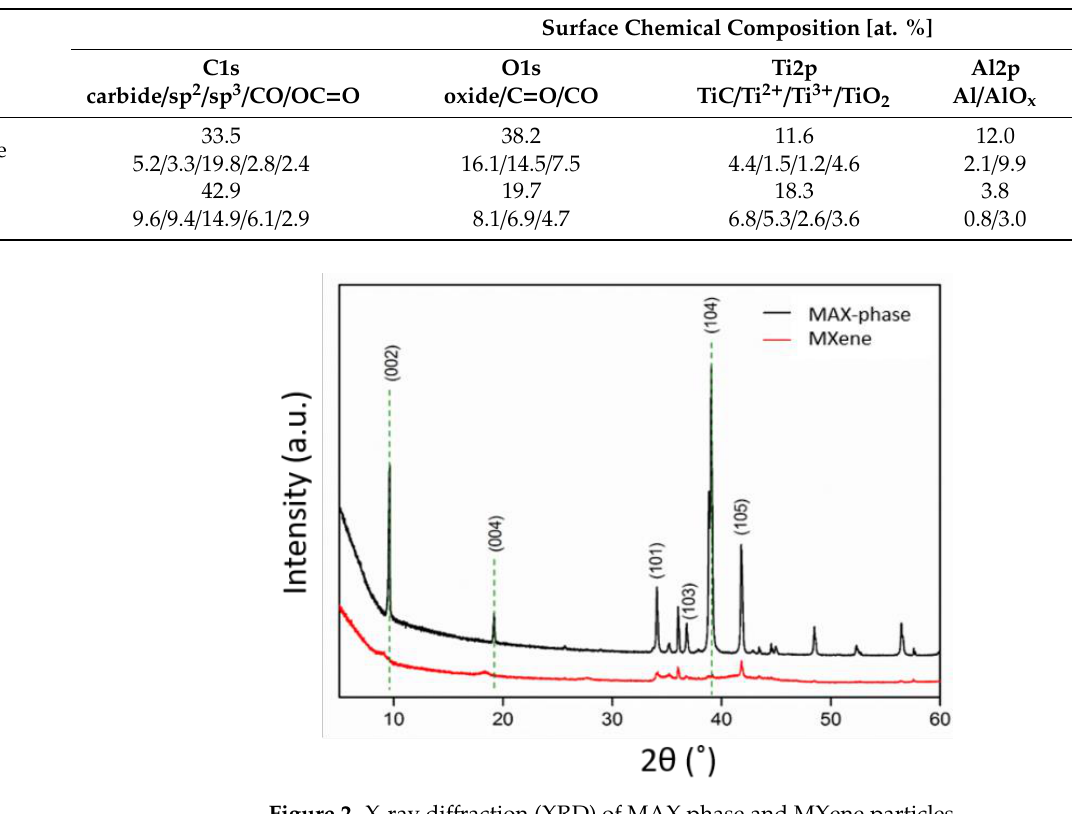
Figure 1. ( A ) SEM of MAX phase and ( B ) TEM image and ( C ) atomic force microscopy (AFM) image with line profile of MXene particles. Table 1. The apparent surface chemical composition as determined by X-ray photoelectron spectroscopy (XPS).